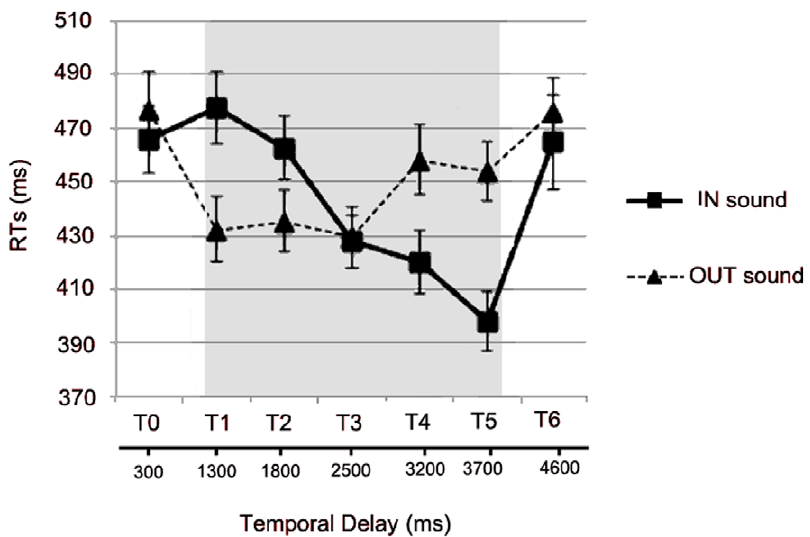
Figure 2. Effects of IN and OUT sounds on tactile processing. Mean RTs (and S.E.M.) to the tactile target at different temporal delays (from T0 to T6) for IN (filled line) and OUT (hatched line) sounds. The shaded region indicates the duration of the sounds.